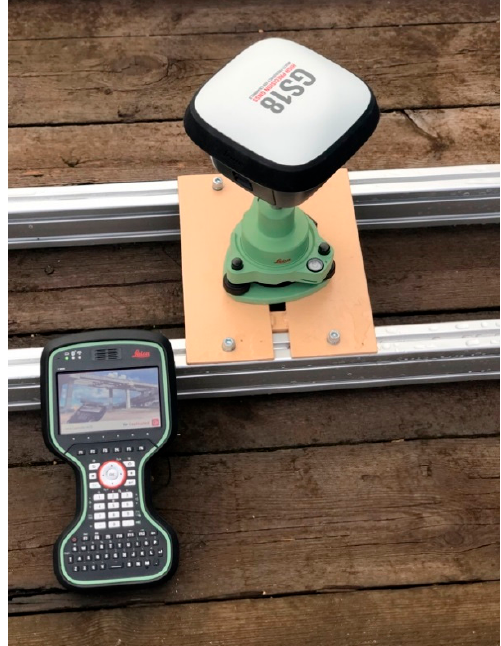
Figure 2. A LEICA GS-18 receiver used during the surveys.